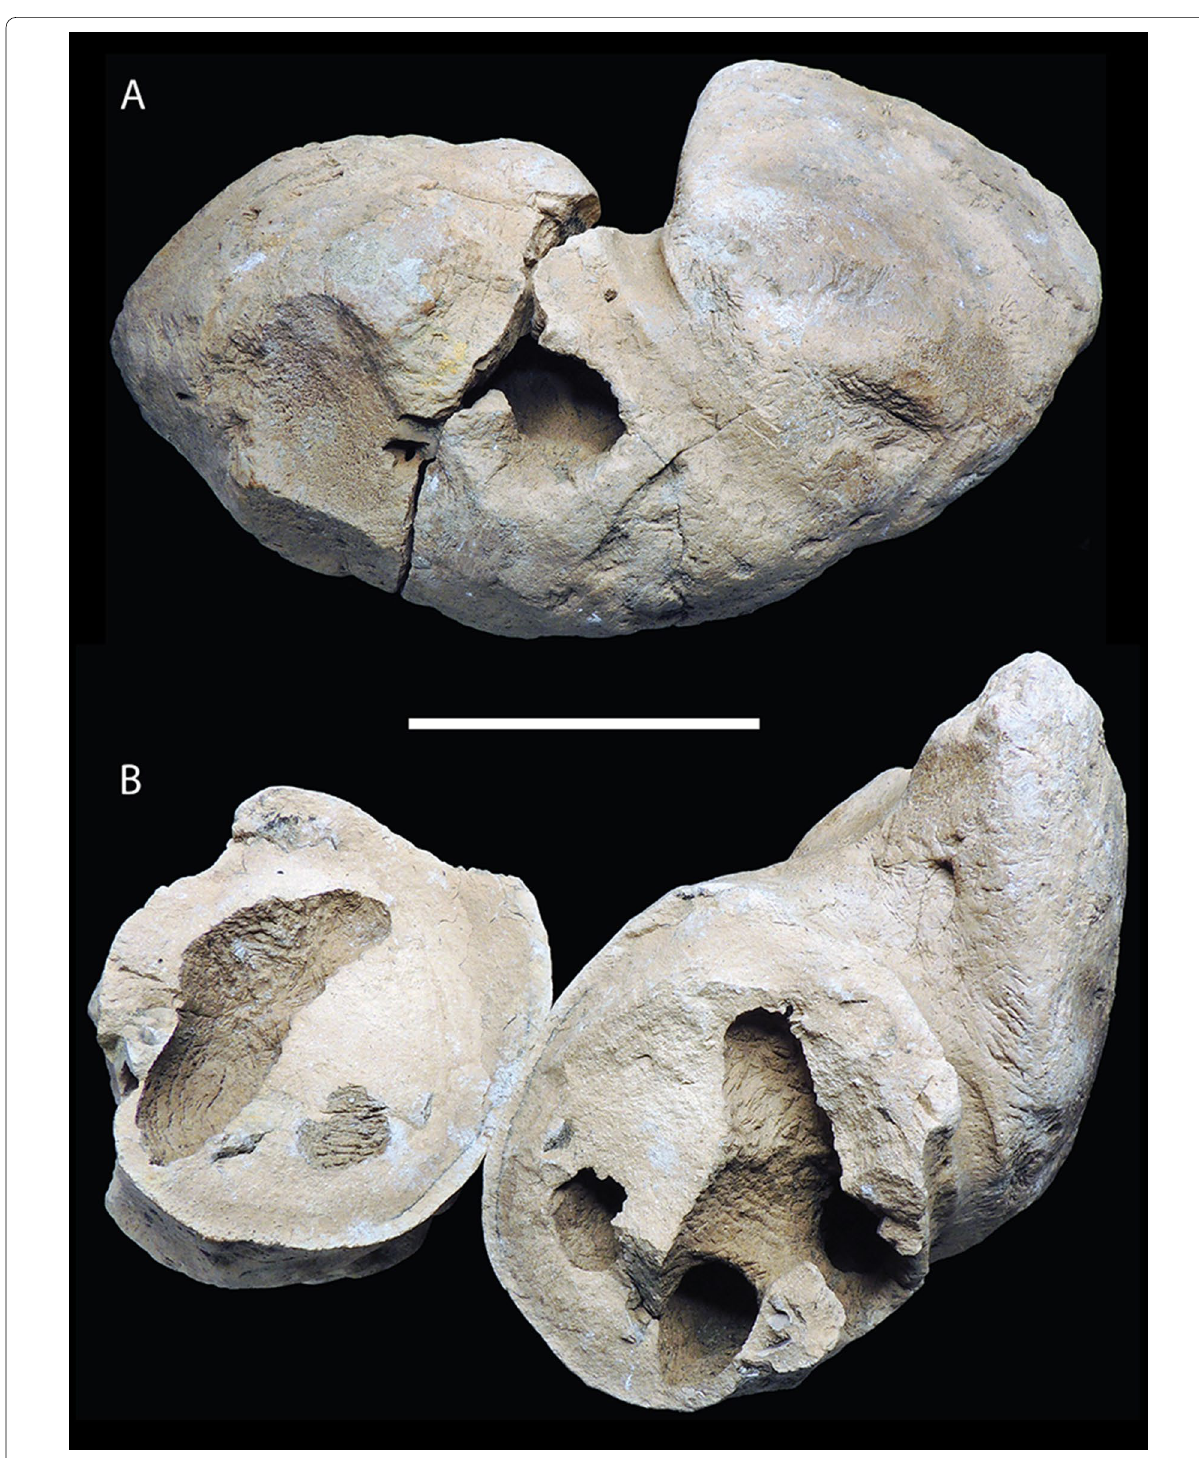
Fig. 3 CMM-V-5805, holotype of Transexcrementum cuniculus igen. et isp. nov., a burrowed vertebrate (probably crocodilian) coprolite from Shattuck-Zone 14 of the Plum Point Member of the Calvert Formation, Calvert Cliffs, Maryland, U.S.A. A General overview of the specimen, showing the circular opening through which the coprolite was burrowed. B The coprolite opened up along the crack seen in A , showing the interconnected cylindrical burrows within the coprolite. Notice the linear striations on the walls of the burrows. Scale bar equals 50